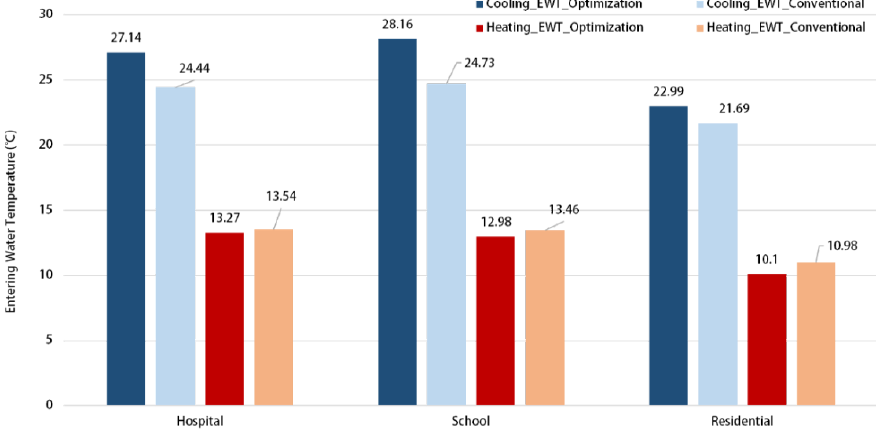
Figure 15. Comparison of entering water temperature (EWT) according to the optimization results by building type.